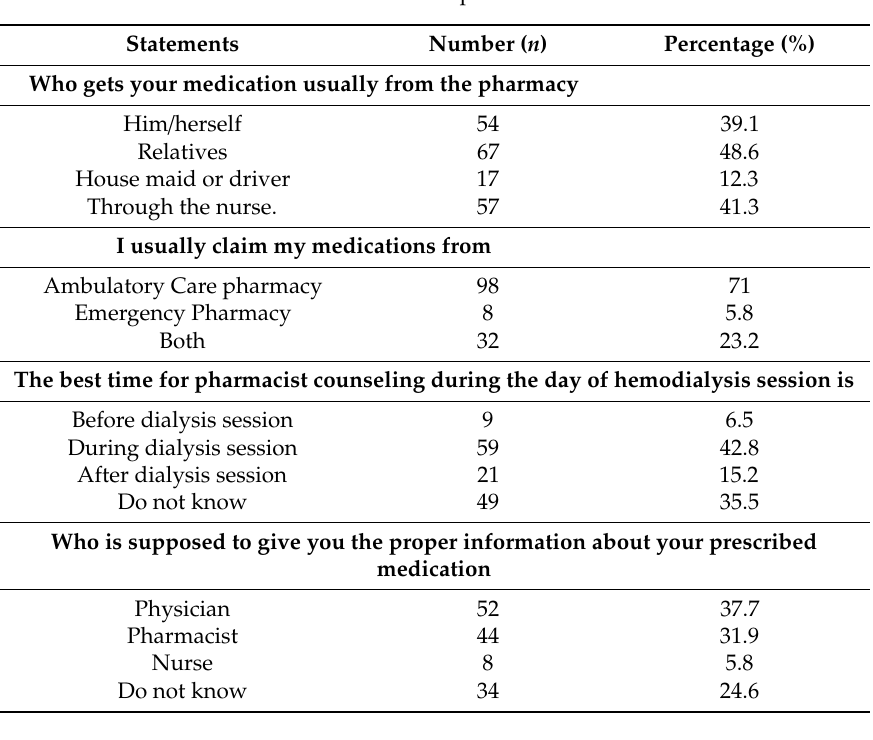
Table 2. Patient preference.